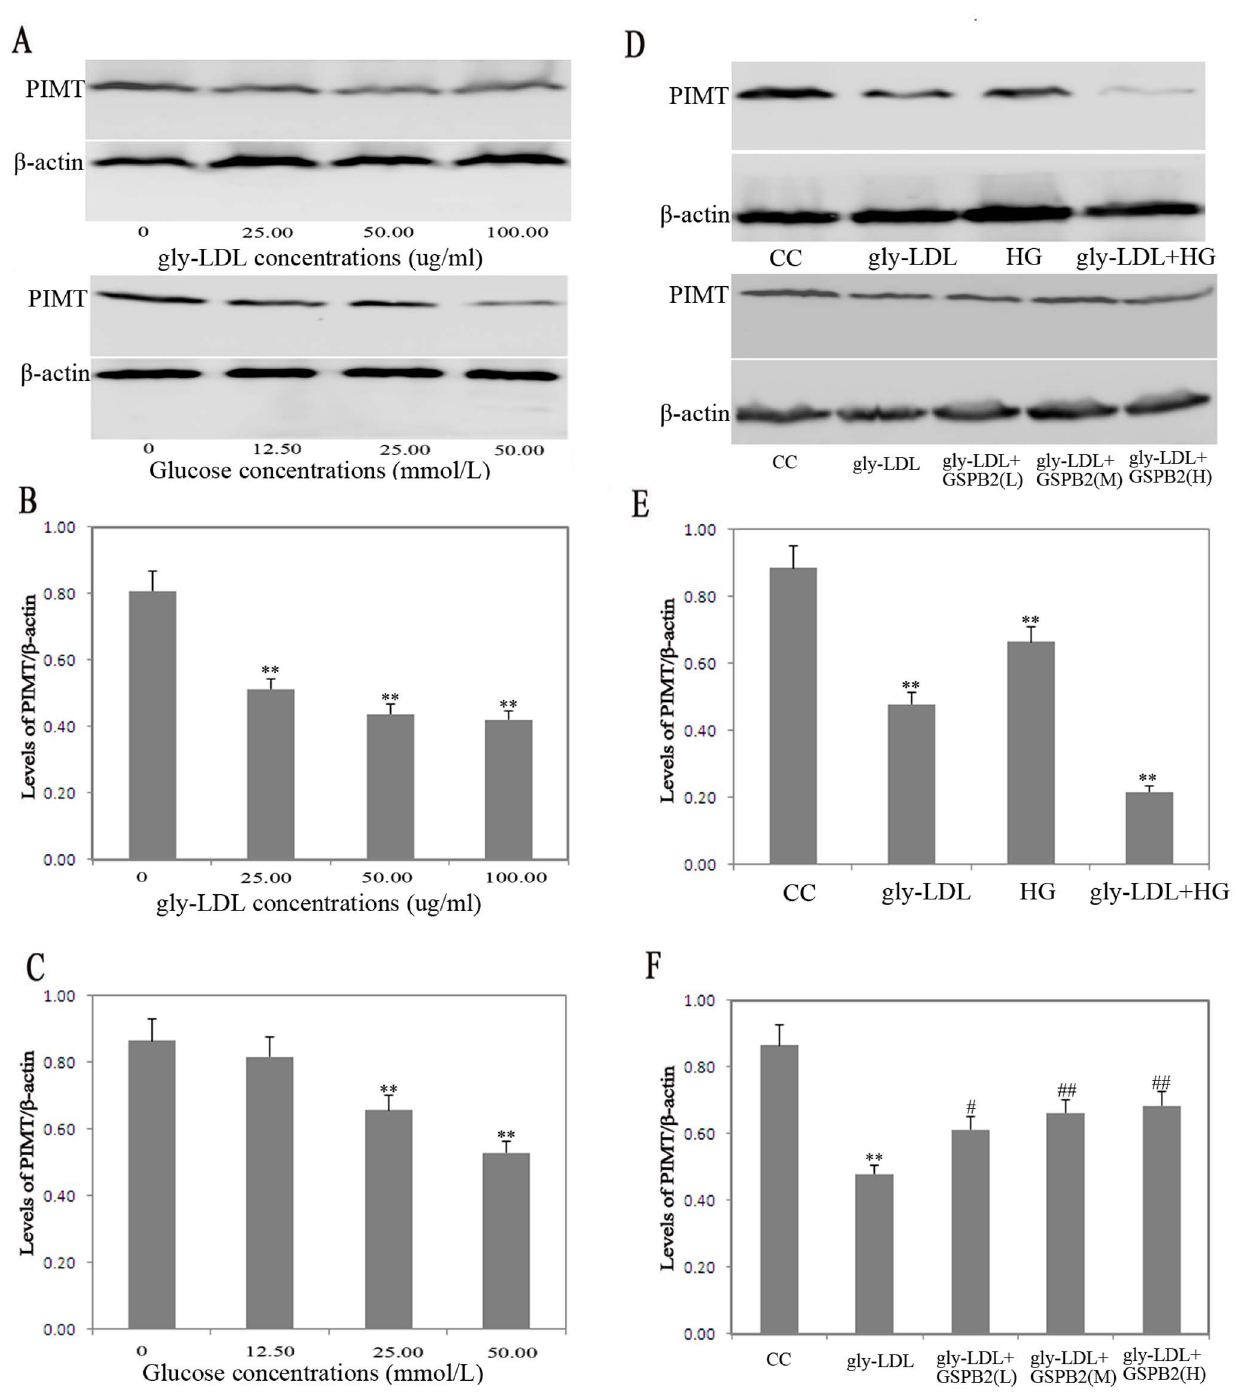
Figure 3. Effects of gly-LDL or high glucose on the expression of PIMT in HUVEC. A, B, C: Effects of different concentrations gly-LDL or D- glucose on the expression of PIMT in HUVEC at 48 h. D, E: Effects of gly-LDL (50.00 m g/ml) or/and high glucose (25.00 mmol/L, HG) on the expression of PIMT in HUVEC at 48 h. D, F: Effects of GSPB2 on the expression of PIMT in HUVEC treated by gly-LDL at 48 h. GSPB2(L): 2.5umol/L; GSPB2(M): 5.0umol/L; GSPB2(H): 10.0umol/L. Data were expressed as the expression ratio of PIMT/ b -actin and given as mean 6 SD from three independent experiments. * P , 0.05, ** P , 0.01 compared with CC group; # P , 0.05, ## P , 0.01 compared with gly-LDL group.